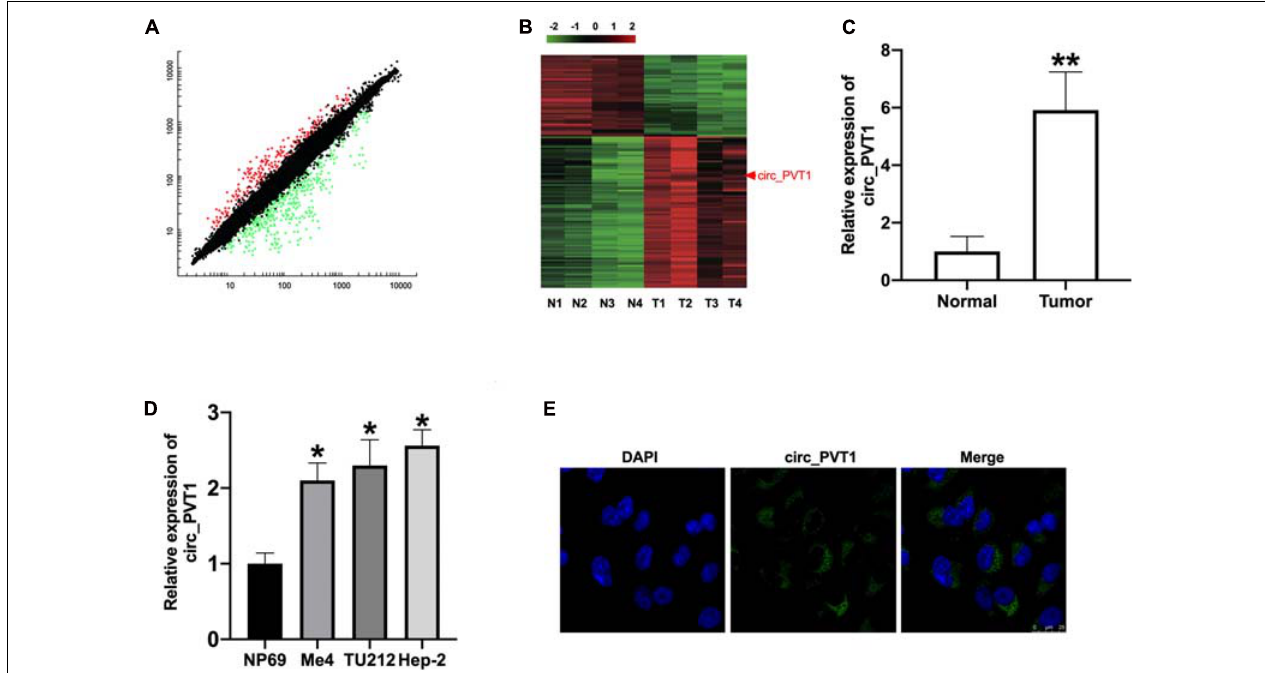
FIGURE 1 | The upregulated level of circ_PVT1 in LC tissues and cells. (A) The differentially expressed circRNAs are shown in LC tumor tissues and adjacent normal tissues. (B) RNA-seq identified differentially expressed circRNAs’ were cross-matched with a microarray generated from four tumor samples and four normal tissues. (C) The expression of circ_PVT1 was detected in LC patients’ tumor tissues and adjacent normal tissues. ** P < 0.01, n = 30. (D) The level of circ_PVT1 in LC cells (Me4, TU212, Hep-2), NP69 cells was indicated as control. * P < 0.05, n = 5. (E) The subcellular localization of circ_PVT1 in Hep-2 cells.